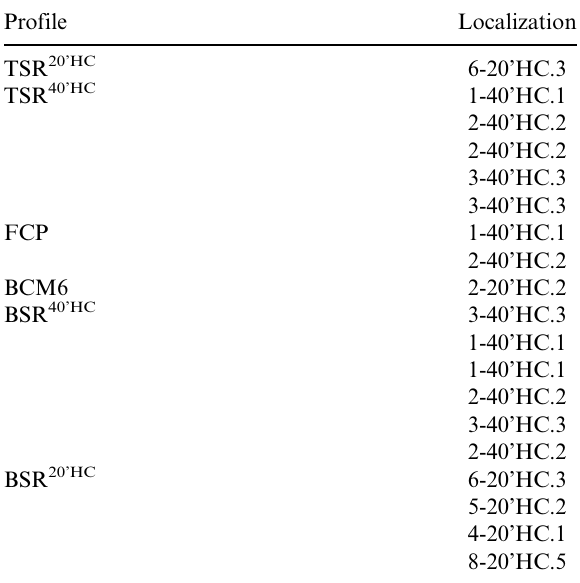
Table 14. Profiles with insufficient resistance